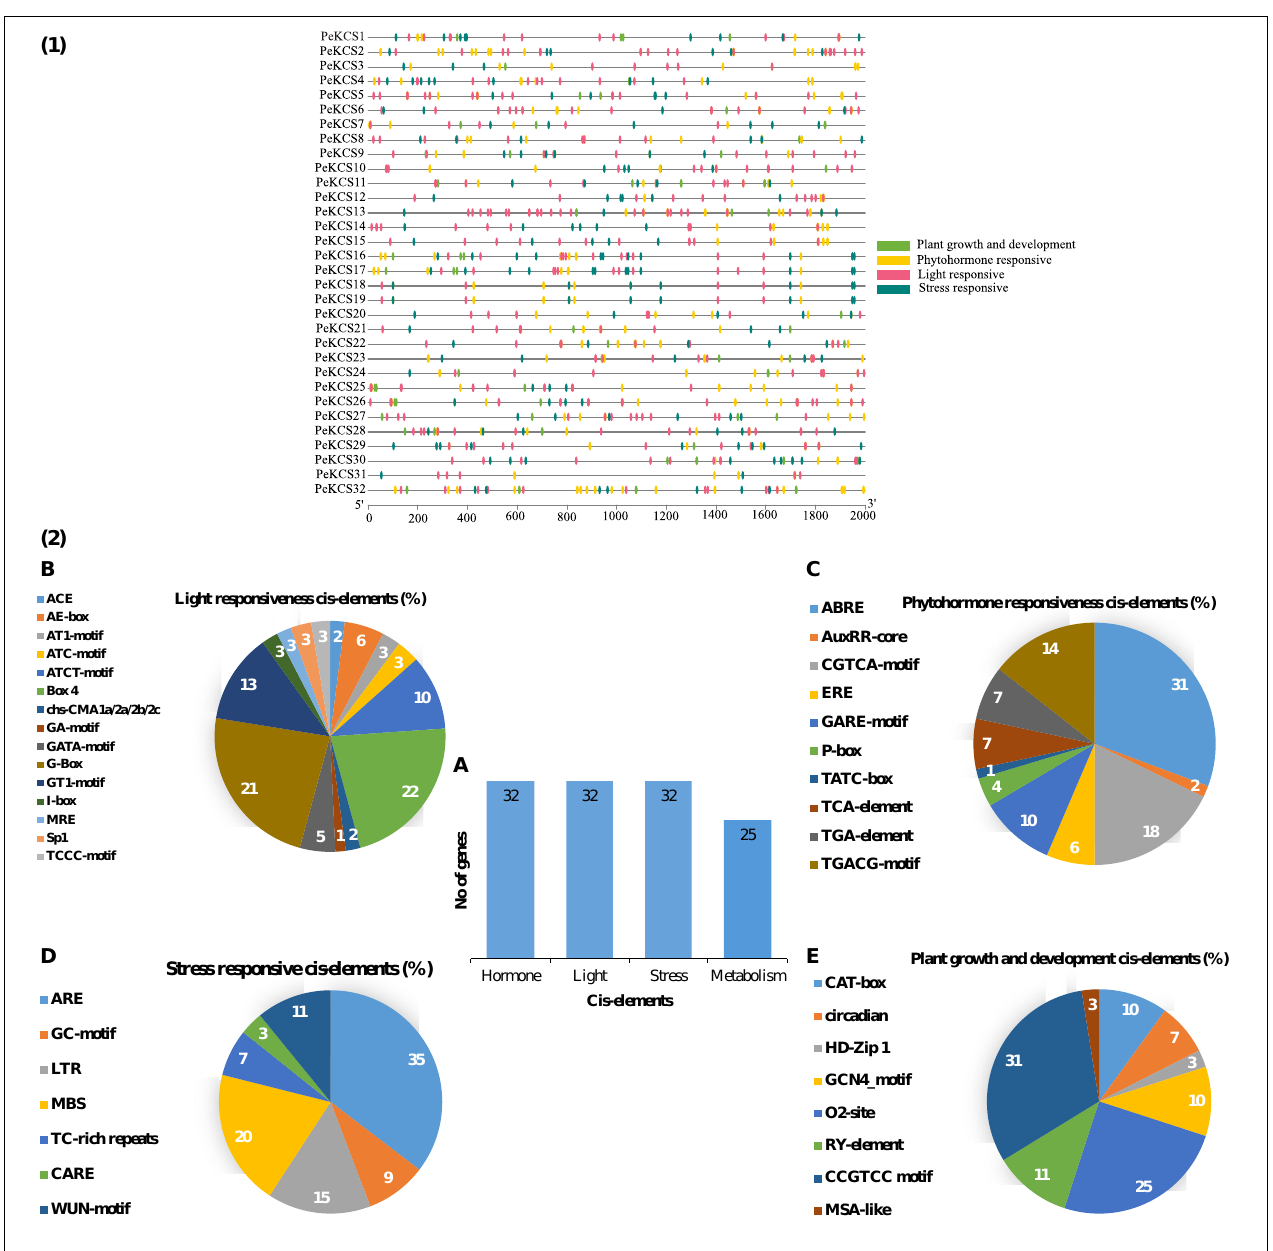
FIGURE 4 | The cis-regulatory element analysis in PeKCS genes (1,2) . (A) The sum number of PeKCS genes involved in four categories of cis-elements and the percentage (%) ratio of the numerous cis-elements from each category is presented in pie charts; (B) plant growth and development responsive (C) phytohormones-responsive, (D) light-responsive, and (E) stress-responsive. Different colors indicate different cis-acting elements and their ratio present in PeKCS